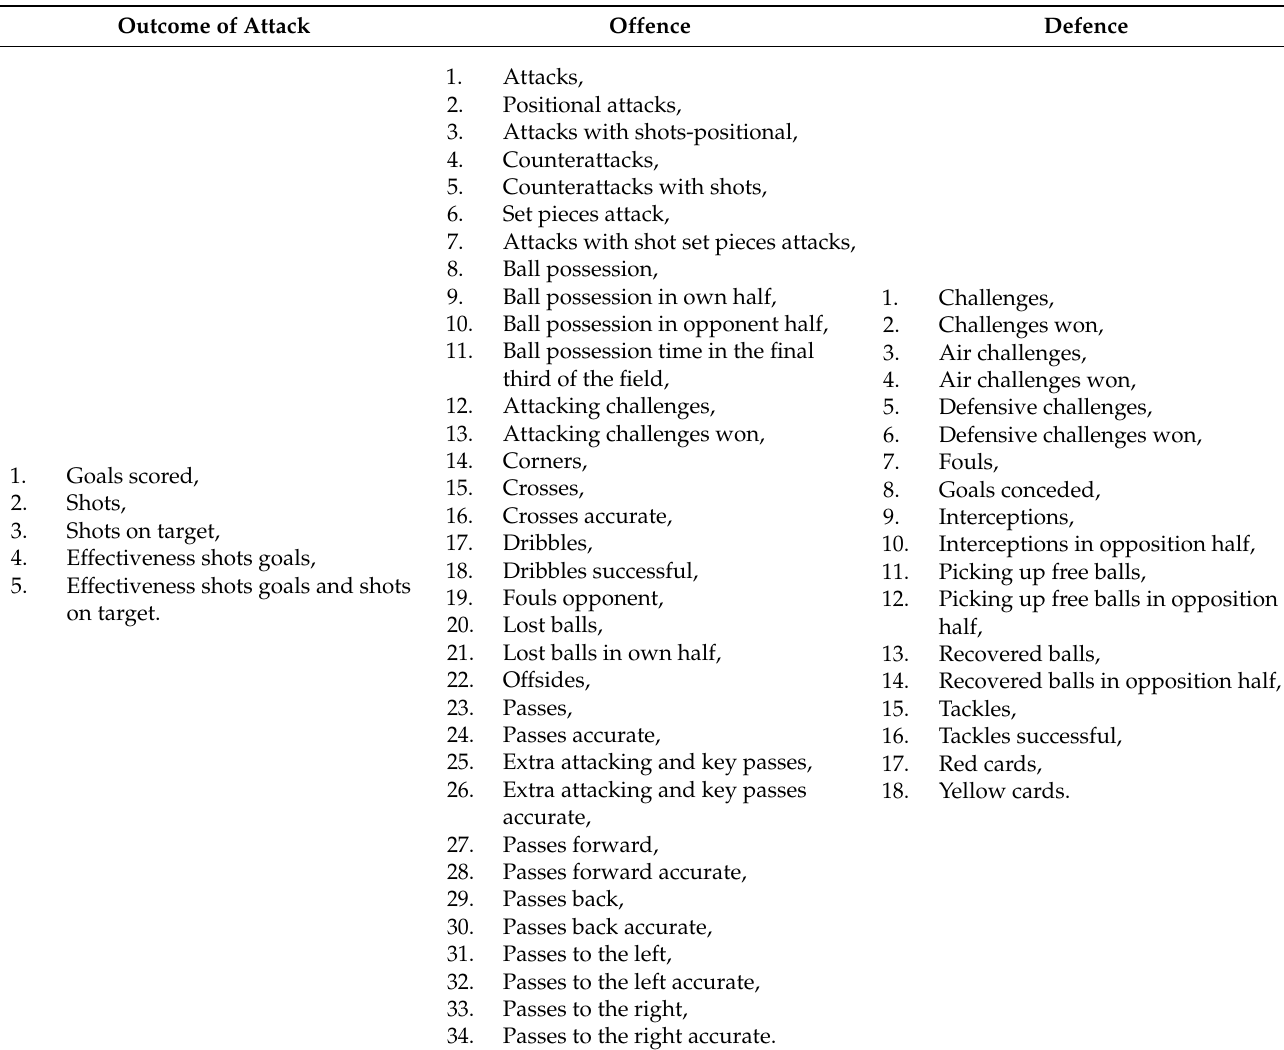
Table 1. Selected performance